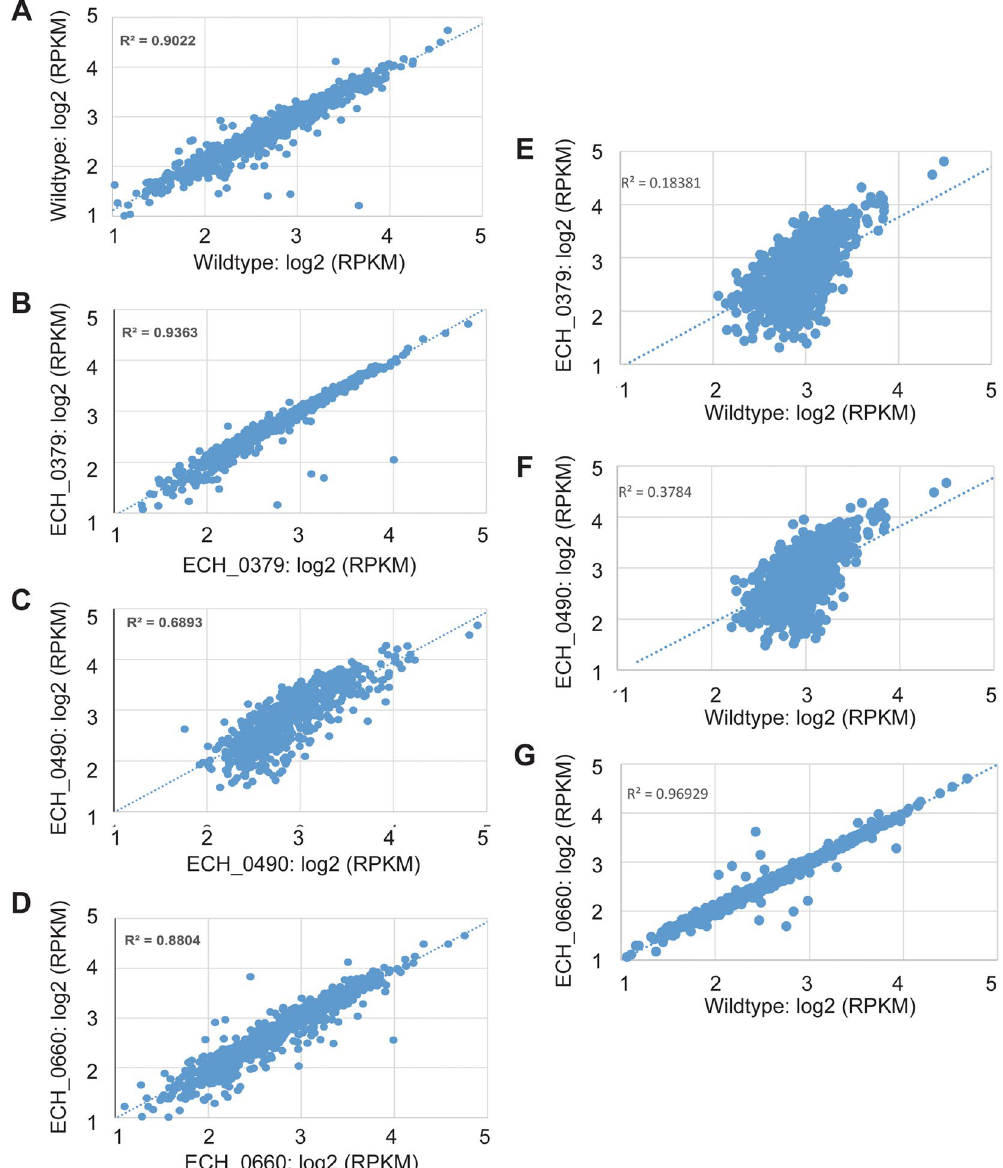
Figure 1. Scatter plot of RNA seq expression analysis. Scatter plots of transcript expression data for replicates of E . chaffeensis wildtype ( A ) and mutants ECH_0379 ( B ), ECH_0490 ( C ), and ECH_066 ( D ) showing a high degree of correlation. Scatter plots of transcript expression data for wildtype vs. mutants: ( E ) wildtype vs. ECH_0379, ( F ) wildtype vs. ECH_0490, and ( G ) wildtype vs. ECH_0660. Transcripts with ≥ 1 FPKM and minimum of 10 mapped reads were used. The plot is on a log-transformed